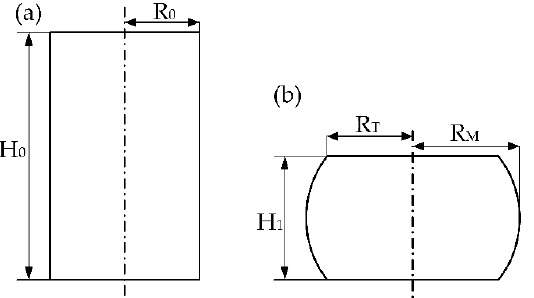
Figure 4. Diagrams of the sample before and after compression: ( a ) before compression; ( b ) after compression.